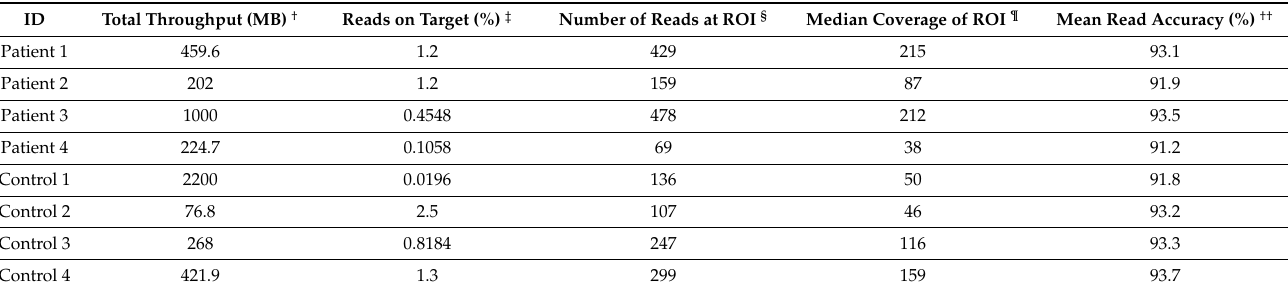
Table 1. Quality control of nanopore sequencing